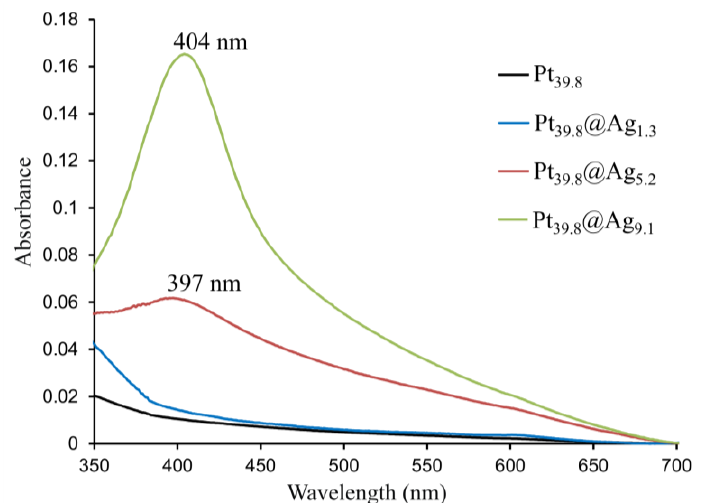
Figure 4. UV-Vis spectra for platinum core particle (39.8 nm) and Pt with an optimal silver shell thickness of 1.4; 5.2; and 9.1